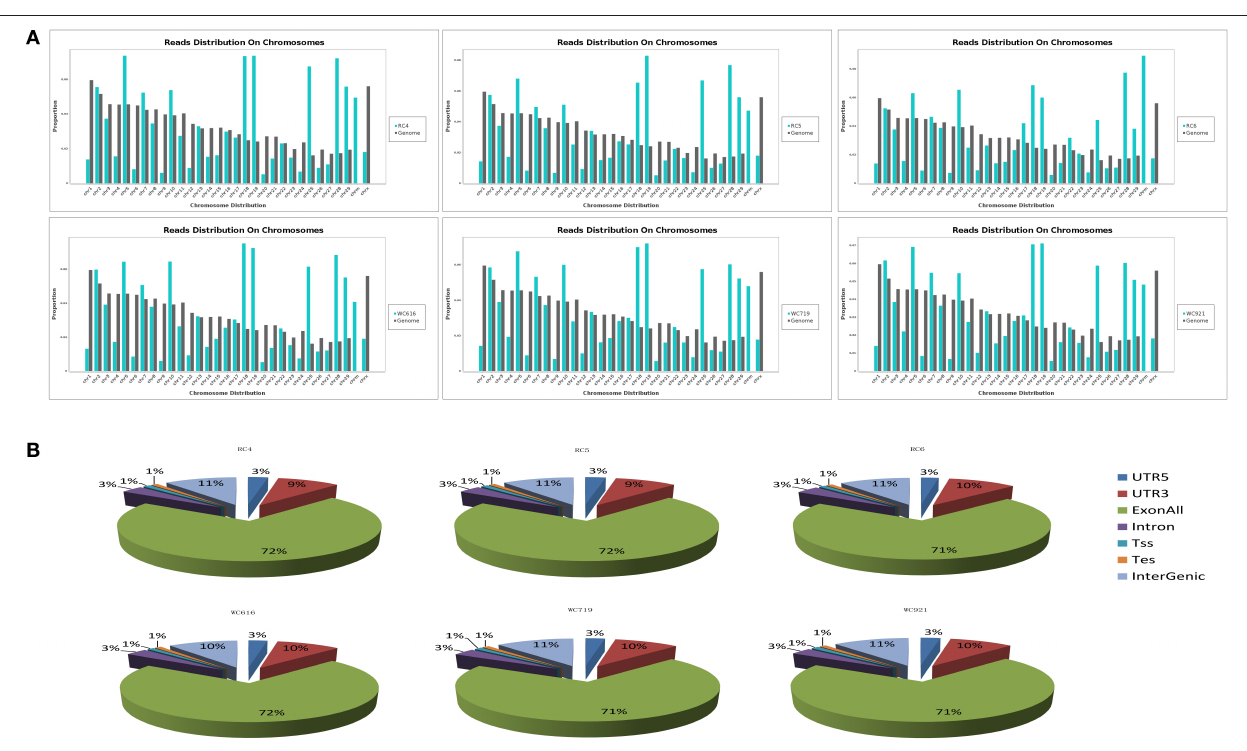
FIGURE 1 | The average distribution coverage at chromosomes of mapped reads. (A) The average distribution coverage at different chromosomes of the genome about mapped reads. (B) Functional genomic elements distribution of messenger RNA (mRNA) reads in different